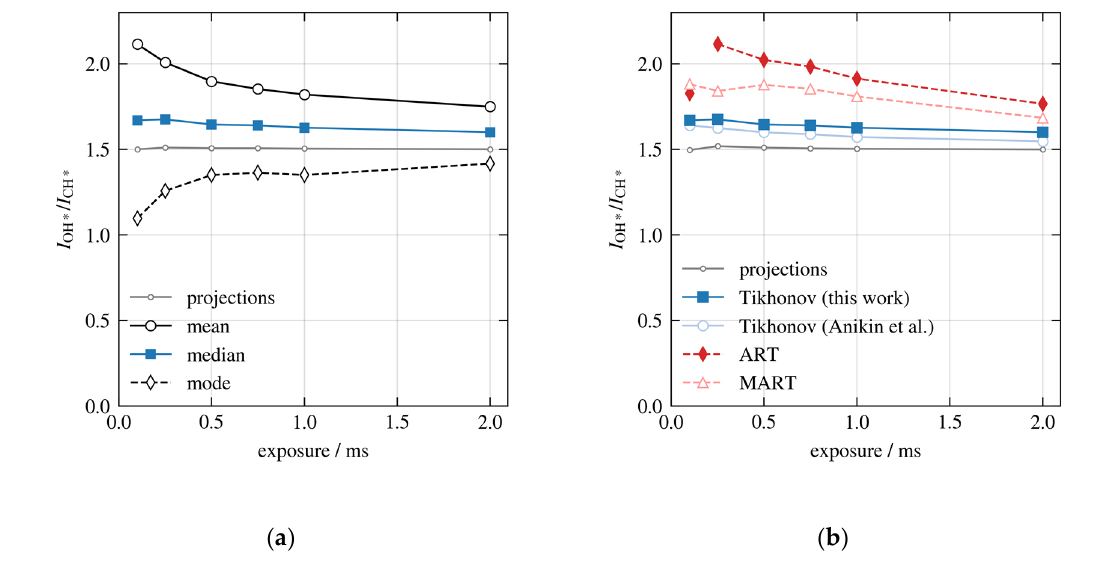
Figure 20. ( a ) Statistical measures of the intensity ratio distribution in turbulent flames as a function of exposure time and when using the reconstruction algorithm in Equation (3). ( b ) Comparison of the median intensity ratio in turbulent diffusion flames between different reconstruction algorithms. Also shown is the median intensity ratio obtained directly from the radon projections.